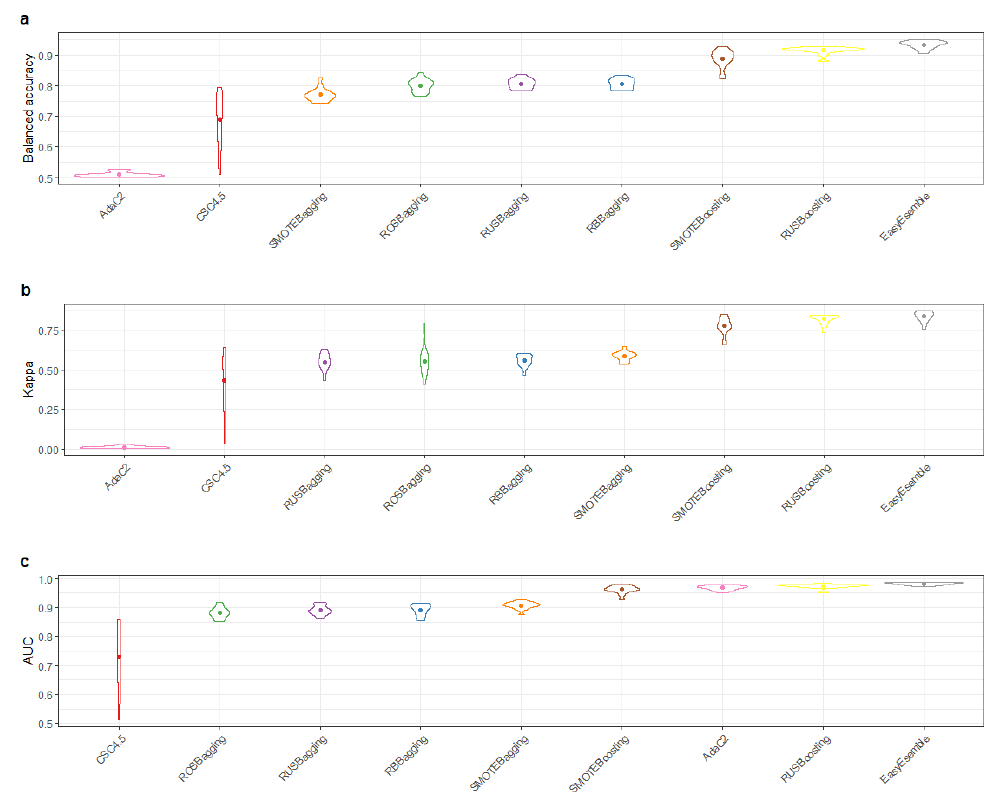
Figure 2. Violin plot showing a full performance distribution of classifiers as measured by balanced accuracy ( a ), Cohen’s kappa ( b ), and AUC ( c ) metrics. Classifiers are arranged in descending order based on their mean value (shown as dots in the